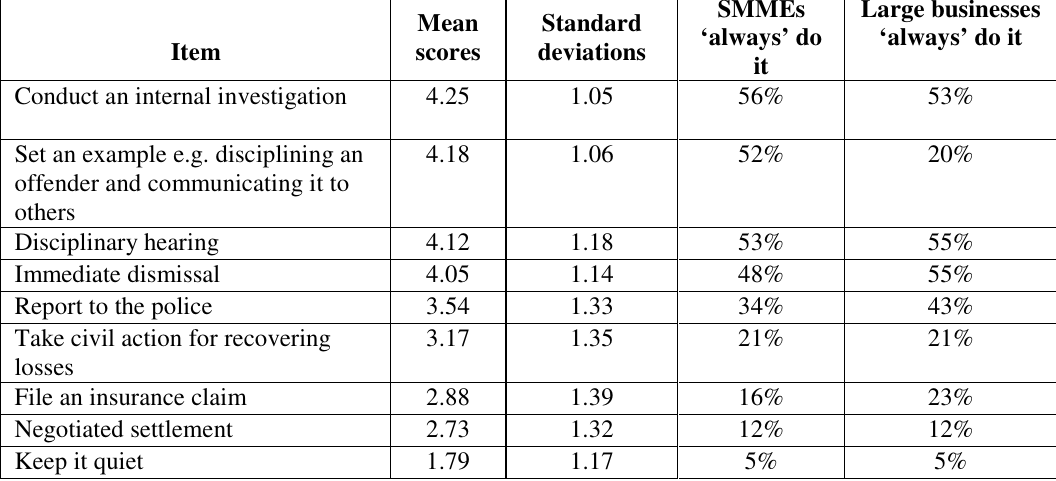
Table 4: Actions taken upon the discovery of fraud